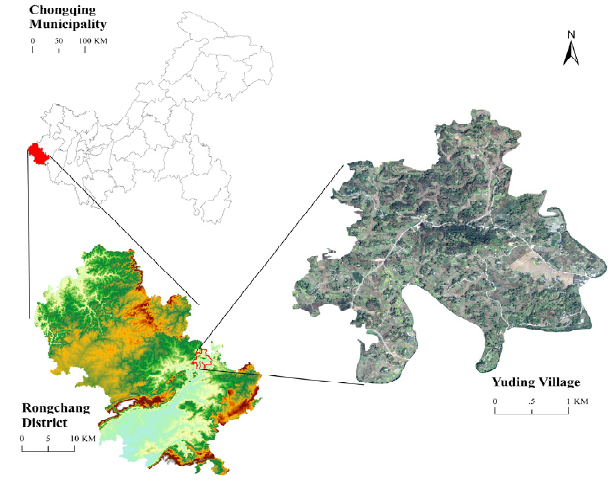
Figure 2. Location of Yuding Village.